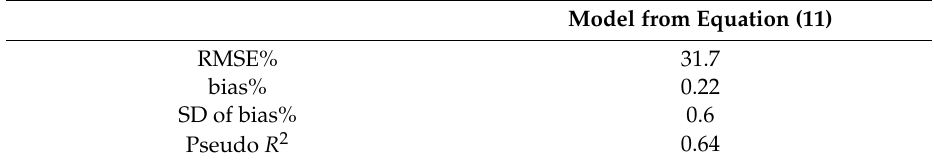
Table 6. Evaluationofthefinalnon-linearlogisticregressionmodelfromEquation(11);SD = standarddeviation.